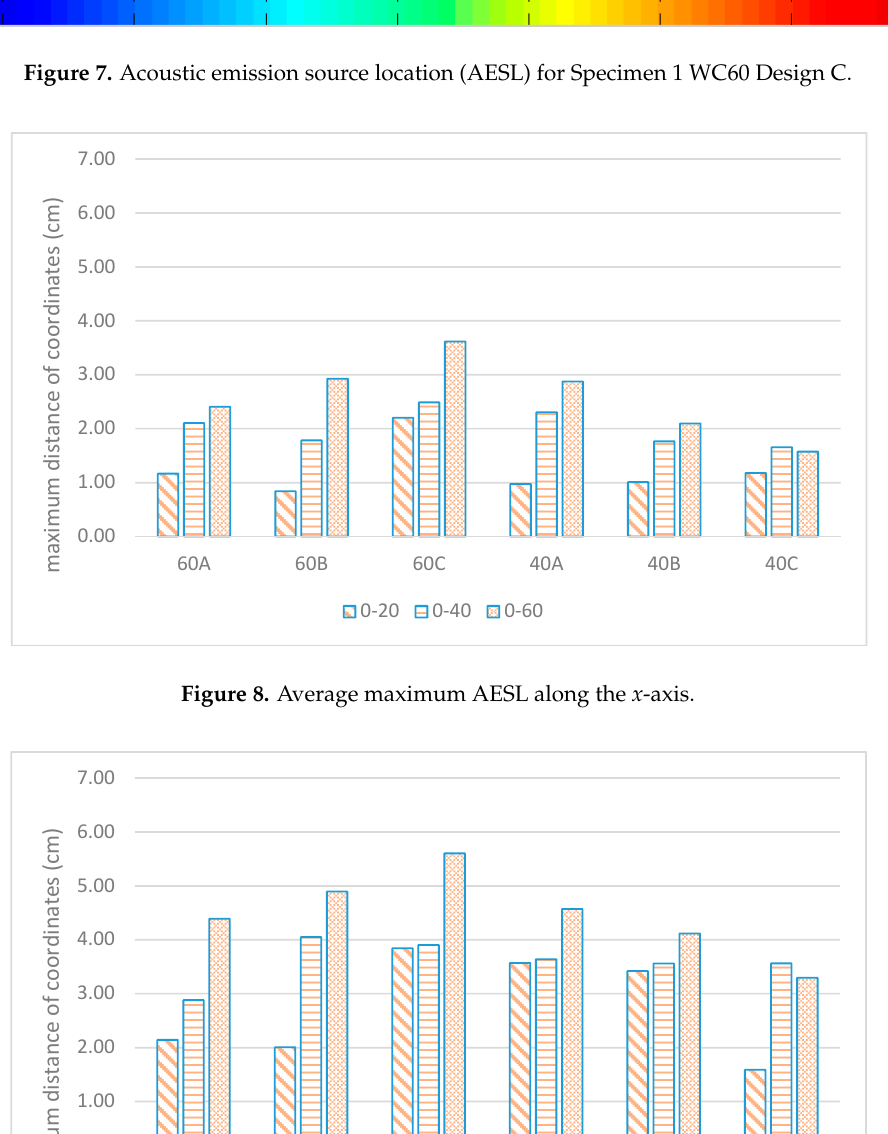
Figure 9. Average maximum AESL along the y -axis.